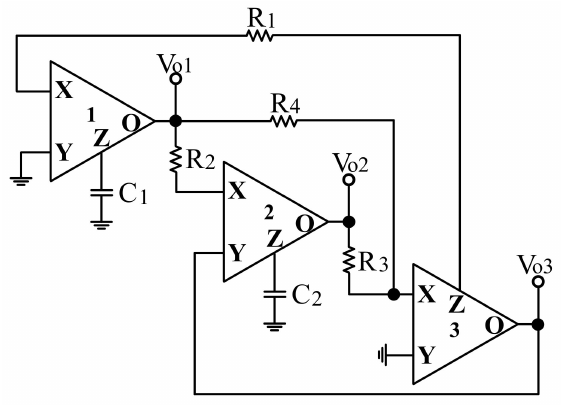
Figure 4. The proposed quadrature sinusoidal oscillator using the filter in Figure